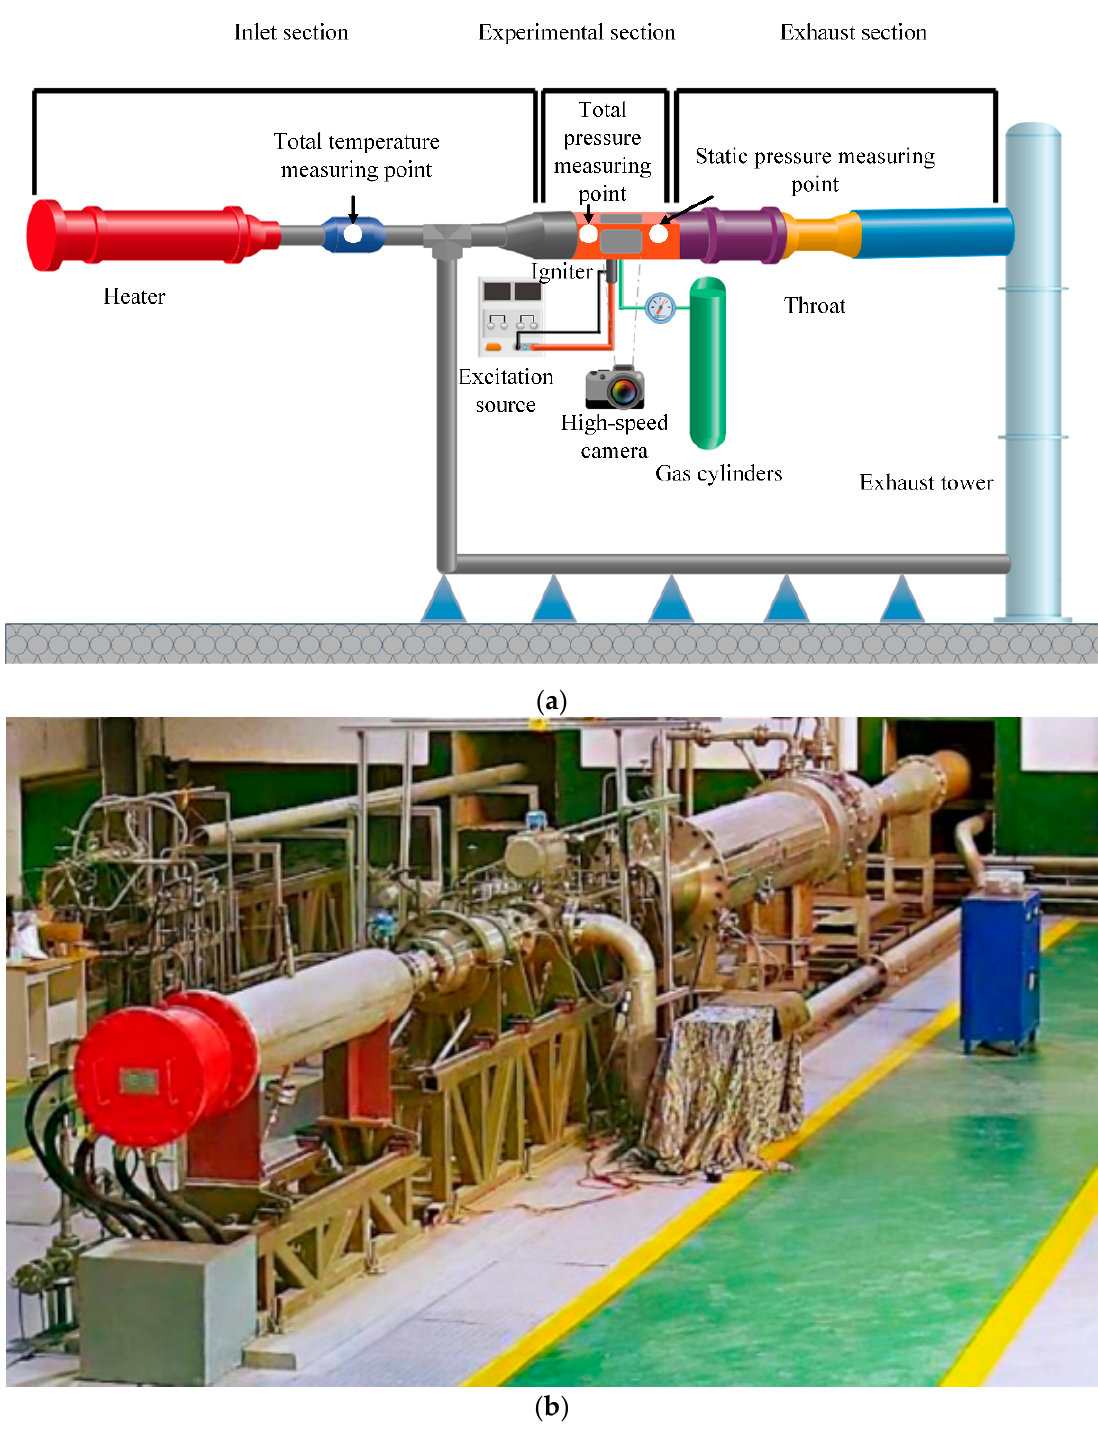
Figure 3. Hyperburner ignition experimental system: ( a ) schematic; ( b ) physical map. The hyperburner test bench includes an inlet section, an experimental section, and an exhaust section. In the inlet section, an electric heater with a maximum output of 200 kW is used to adjust the incoming flow temperature. The cross-sectional area of the experi- mental section is 180 mm (height) × 150 mm (width). A hyperburner-integrated flame sta- bilizer was placed in the experimental section, and the schematic diagram is shown in Figure 4. A throat was placed in the exhaust section to adjust the maximum Mach number.